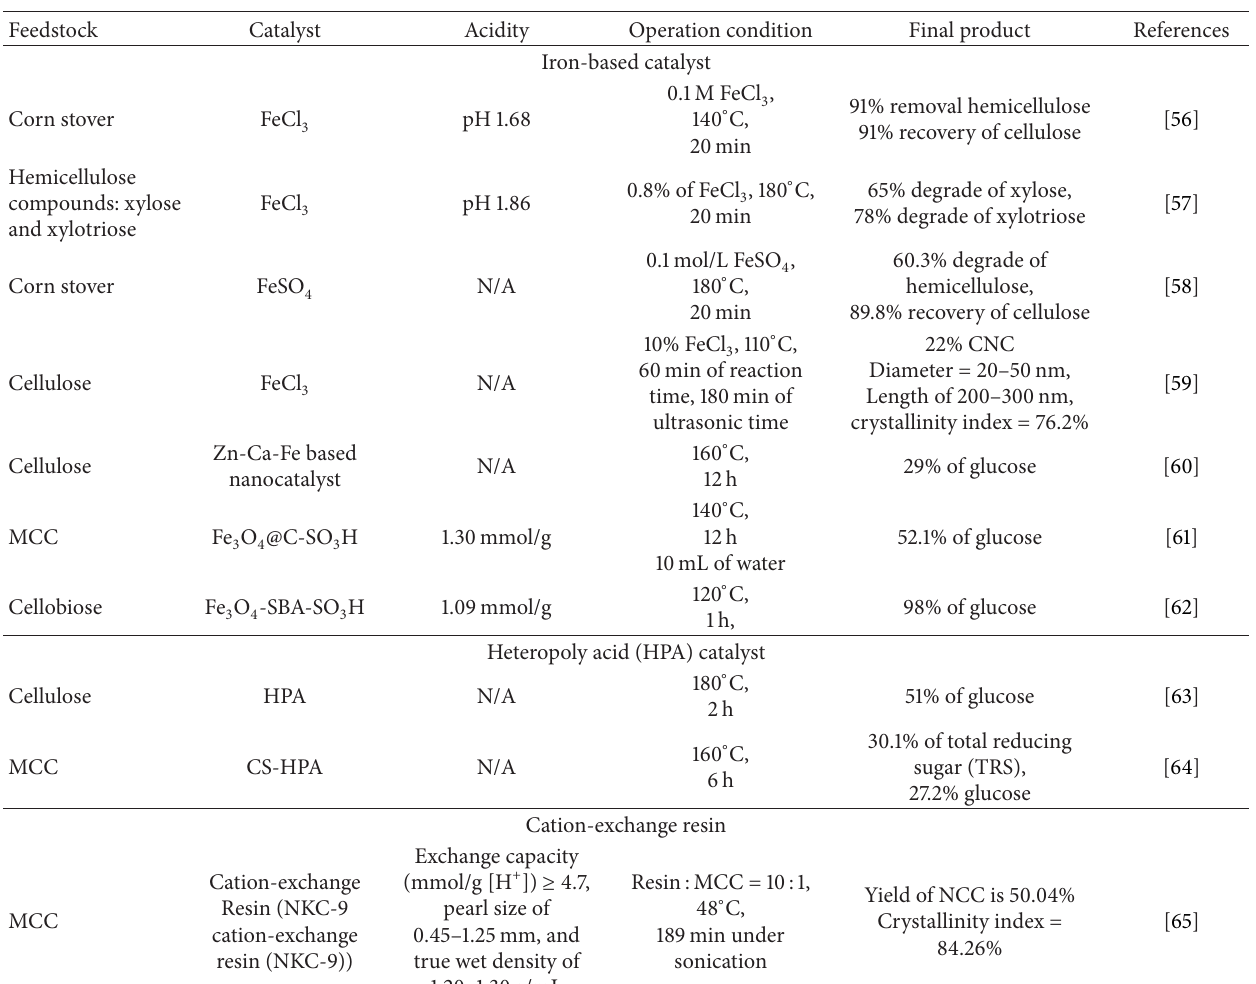
Table 6: Solid acid catalyzed hydrolysis for nanocellulose